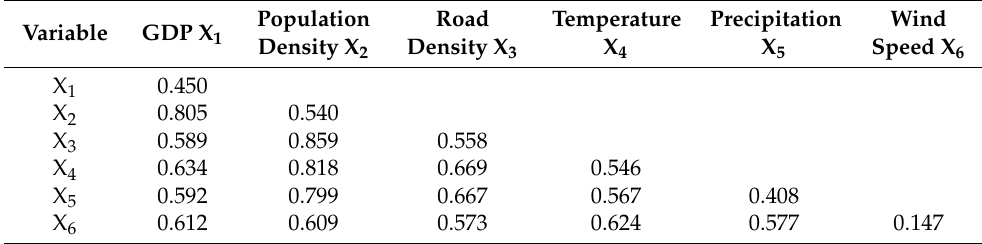
Table 7. Interaction detector results for